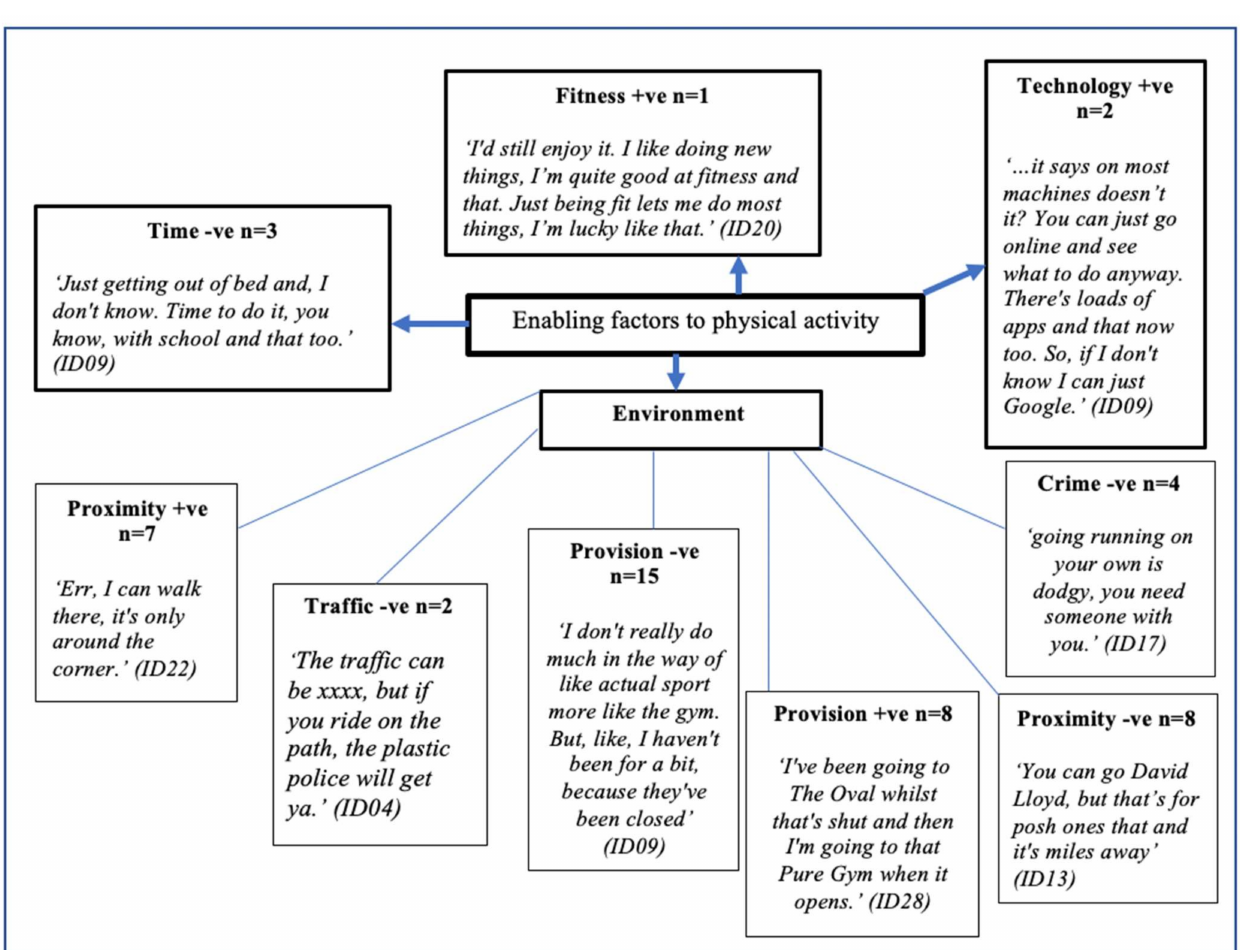
Figure 4. Enabling factors to physical activity. +ve = positive; − ve =